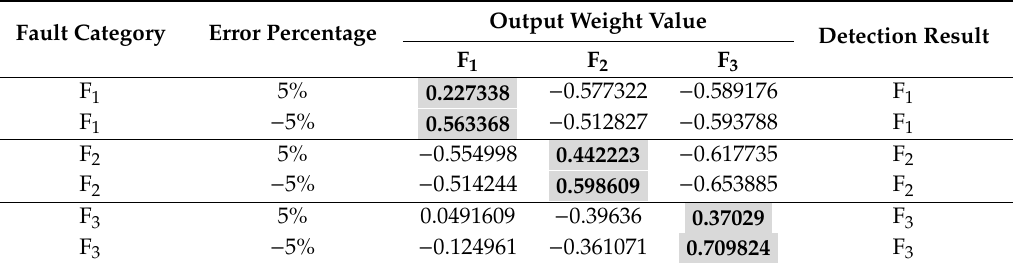
Table 6. Fault detection results under the failure of di ff erent switches in a -phase and addition of ± 5% erroneous data (inverter frequency = 60 Hz).